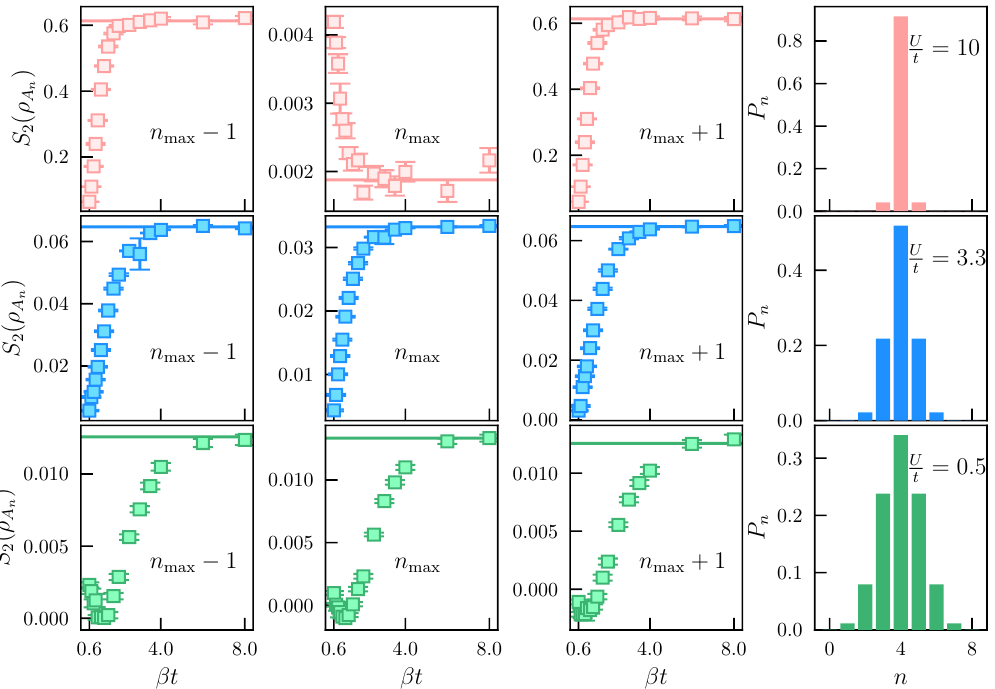
Figure 13: Imaginary time projection length β -scaling of the symmetry-resolved en- ( ρ ) in a 1D Bose-Hubbard chain of L = 8 sites at unit-filling under tanglement S A n 2 an equal spatial bipartition of size ℓ = 4. From top to bottom, the rows correspond to interaction strengths in the superfluid phase ( U / t = 0.5), at the phase transition ( U / t = 3.3), and in the Mott phase ( U / t = 10). The first three columns correspond to entanglement entropies in the maximal local particle number sector n with the largest probability), and the two neighboring sectors n The solid horizontal lines are the exact diagonalization values for each symmetry re- solved entanglement entropy. The rightmost column shows the local particle number distribution P at each of the three interaction n